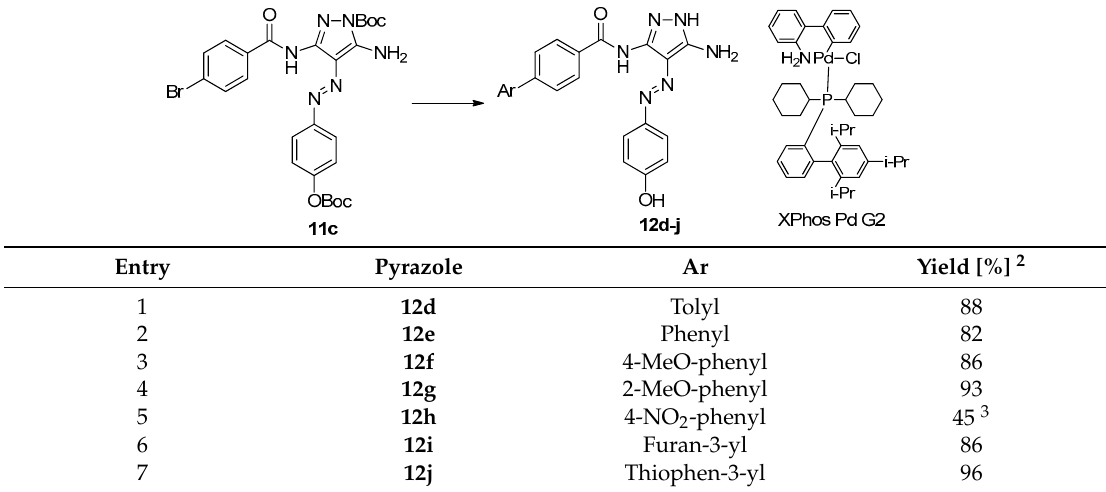
Table 2. Arylation of pyrazole 11c by Suzuki-Miyaura coupling 1 .